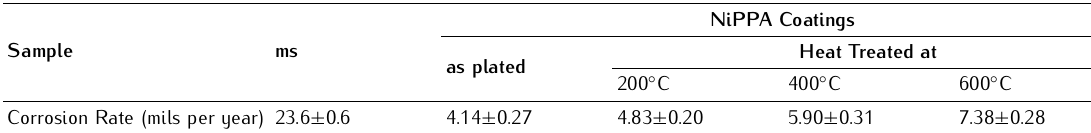
Table 3. Corrosion rate of mild steel (ms), as plated and heat treated coatings from